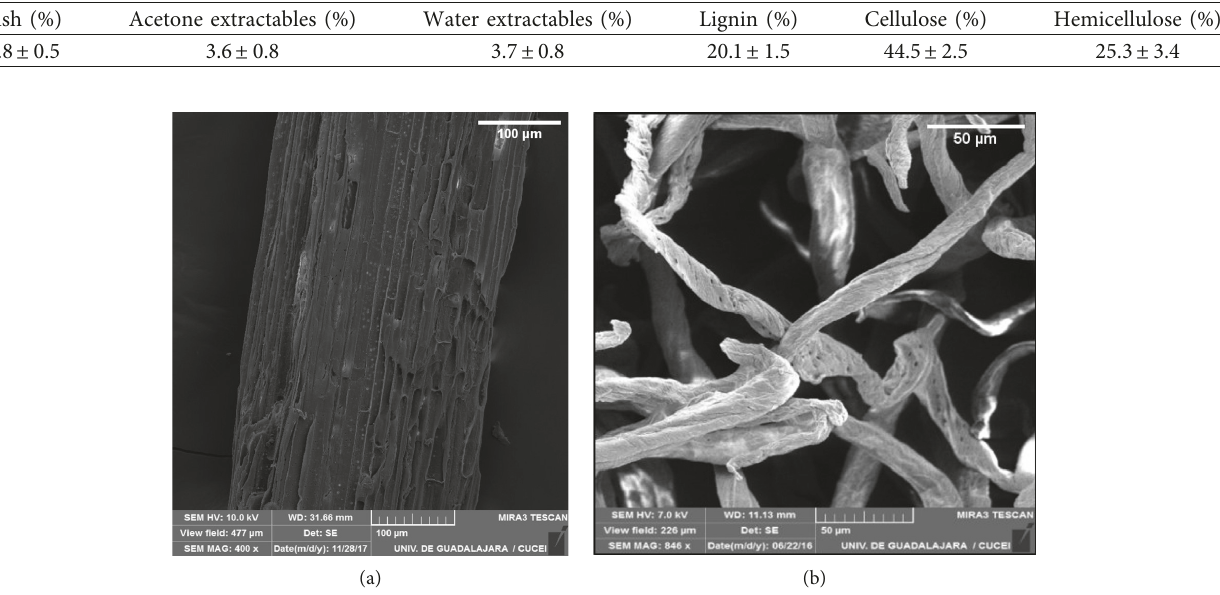
Table 1: Chemical composition of the agave bagasse.